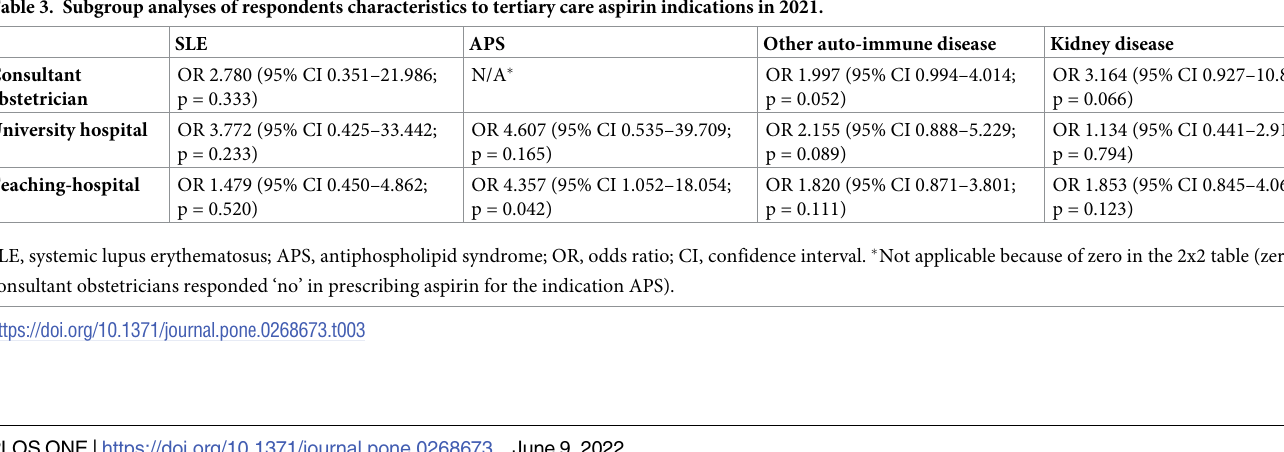
Data are depicted as number (%) or median [IQR]. Chi-square Test is performed on the data depicted as number (%) and Mann-Whitney U Test by data depicted as median [IQR]. GA, gestational age.